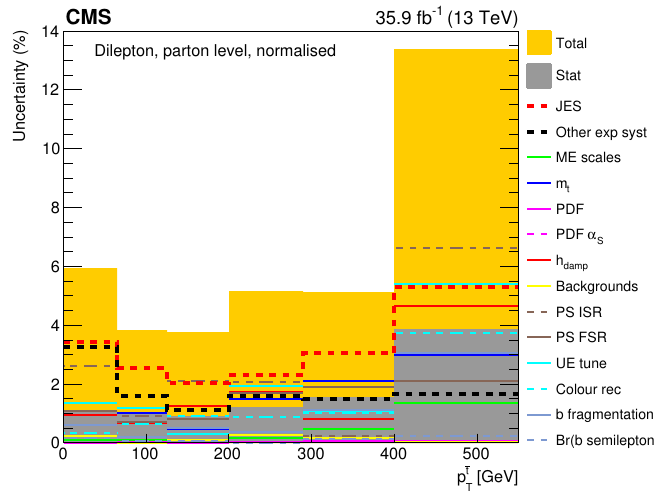
Figure 8 . The contributions of each source of systematic uncertainty to the total systematic uncertainty in each bin is shown for the measurement of the normalised tt production cross sections as a function of p t . The sources a(cid:11)ecting the JES are added in quadrature and shown as a single T component. Additional experimental systematic uncertainties are also added in quadrature and shown as a single component. Contributions from theoretical uncertainties are shown